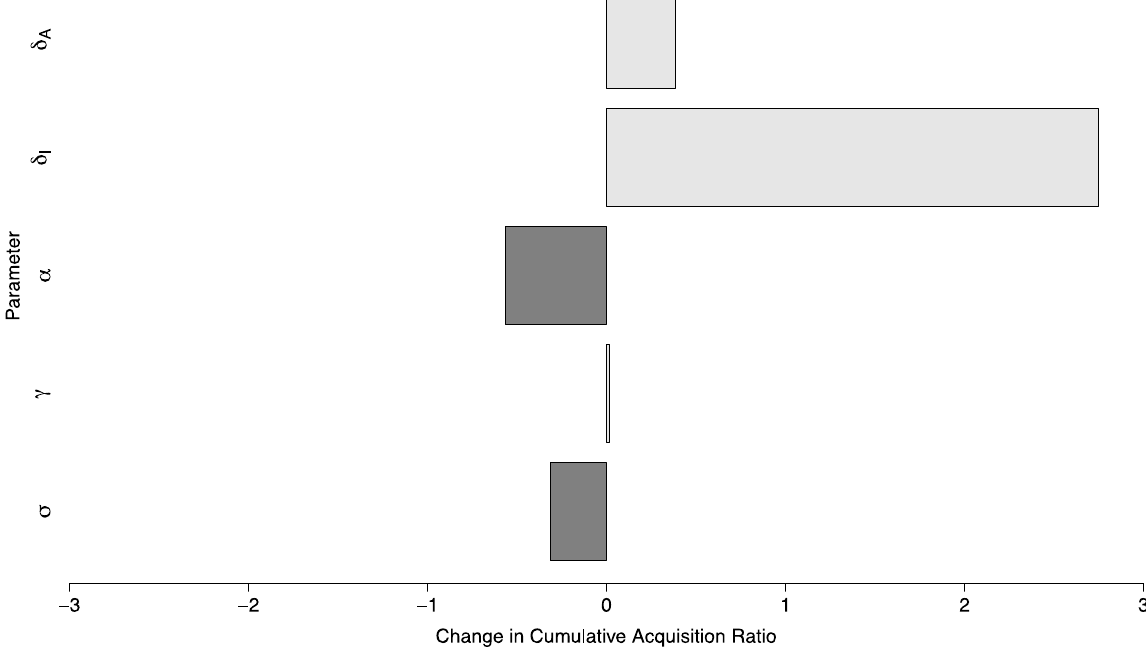
Figure 7. Global parameter sensitivity of the ratio of cases between two campuses with controlled epidemics—one with no in-person sporting events, and one where visitors come from a high prevalence area and mix with the campus community at a high rate. Each bar depicts the change in this ratio per ten-percent change in the value of a specific parameter.